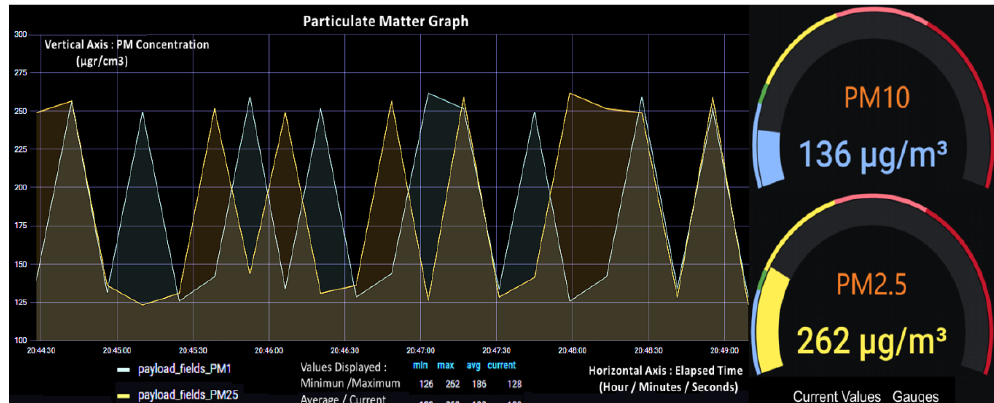
Figure 13. Visualization of Indoor Air Quality data by Grafana server using the Sensirion SPS30 sensor readings. ( Left ) Time-based graphic recording of PM values for the depicted time interval of 5 min, including minimum, maximum, average, and current values. ( Right ) current gauge values of PM 2.5 and PM 10 in µg/cm 3 to be divided by a factor of 10.